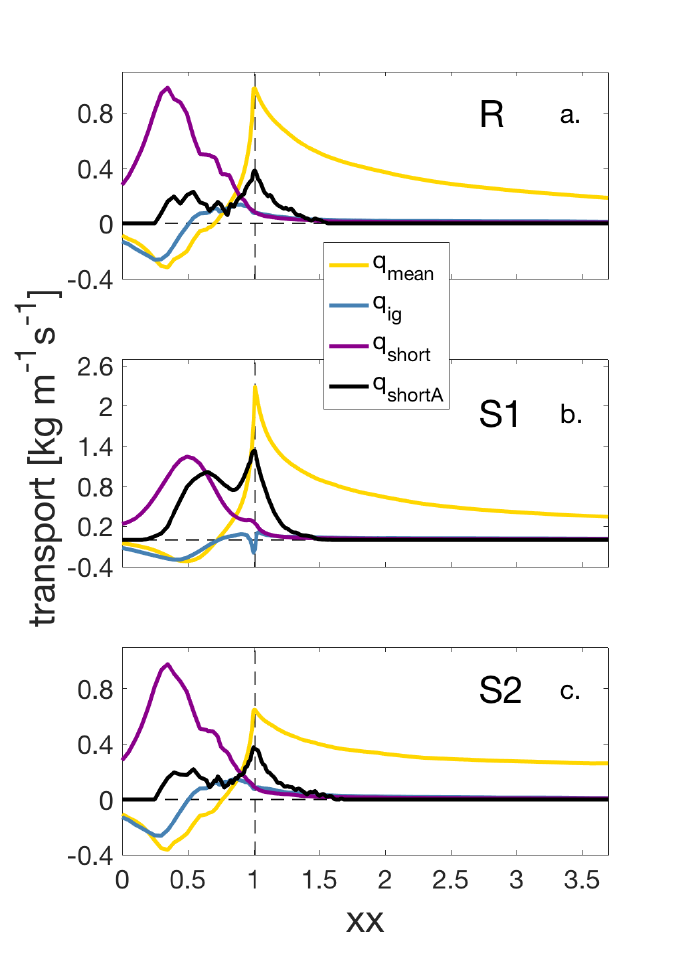
Figure 4. Transport processes q mean , q short , q ig , and q shortA are shown for slopes R ( a ), S 1 ( b ) and S 2 ( c ) on a normalized grid ( xx ) from the beginning of the seaward slopes ( xx = 0) to the back barrier basin ( xx = 3.7). Grid locations before the crest (indicated by the vertical dashed line) indicate output in the same water depth (but not the same distance in reference to the crest, while they are equidistant after the crest (and at the same depth for R and S 1, but not for S 2, see Figure 2). Note that vertical scales are